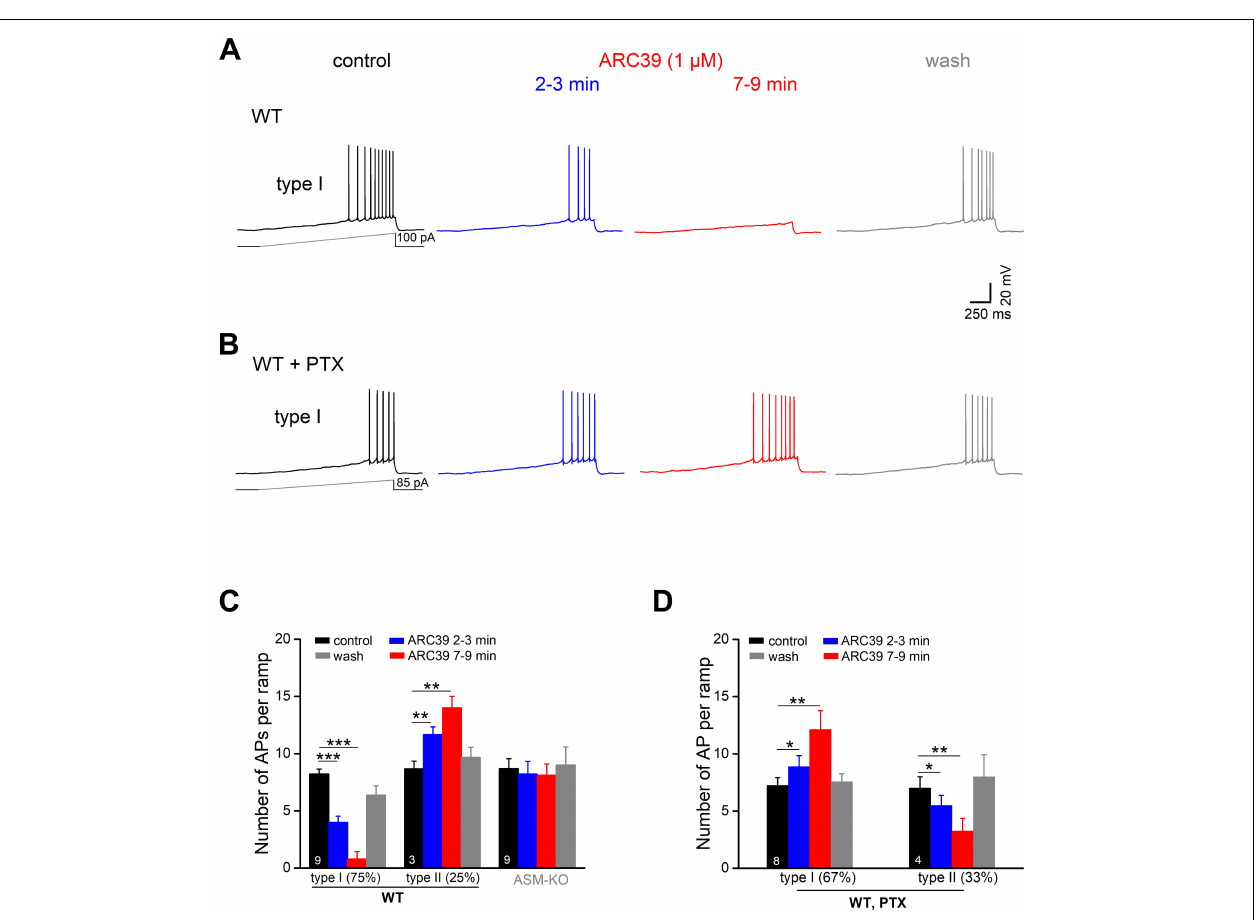
FIGURE 4 | Predominant suppression of CA1 pyramidal cell firing by ARC39 involves GABAergic inhibition. Action potentials (APs) of ventral CA1 pyramidal cells were evoked in current-clamp mode by depolarizing voltage ramp rising from 0 to 50–100 pA within 2 s. All cells were initially held at –70 mV, before